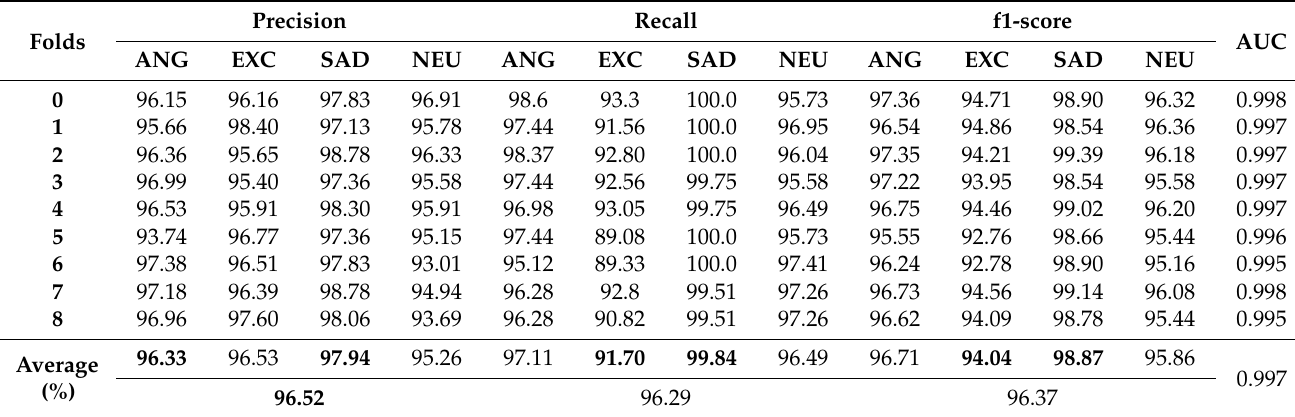
Table 9. Precision, recall, f1-score, and AUC for CNN model with 128